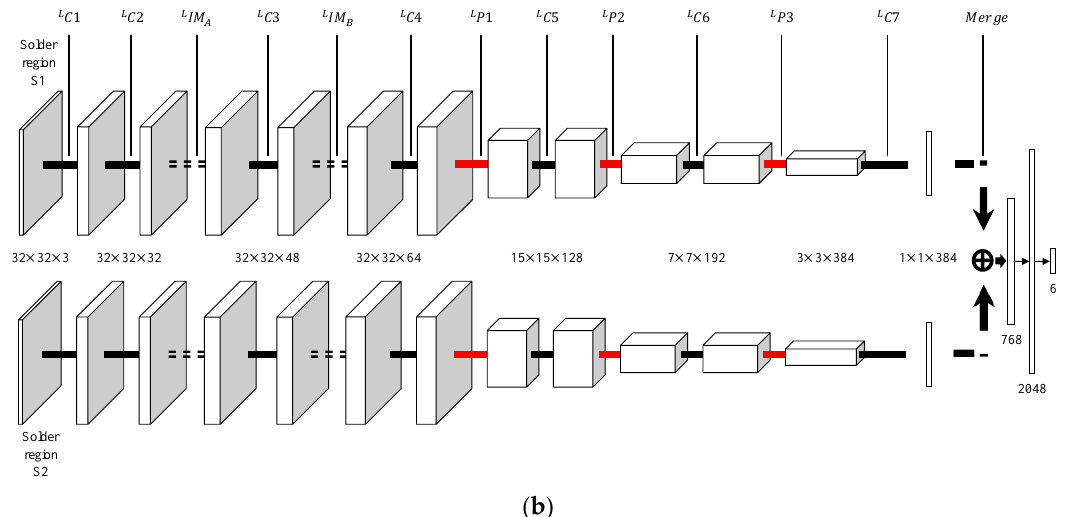
Figure 11. Structures for dual-stream CNNs. ( a ) Early-merge dual-stream CNN. The merge is located at the convolution layer of the network. ( b ) Late-merge dual-stream CNN. The merge is located at the front of the fully connected layer.